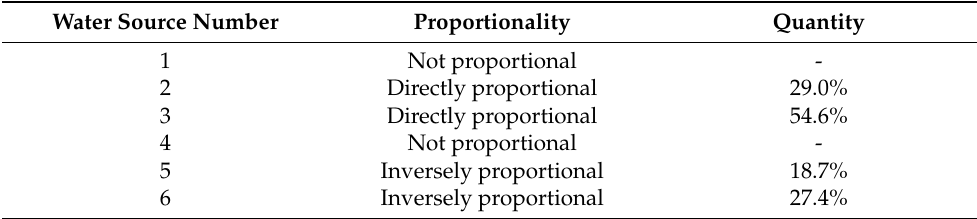
Table 2. Part of the dependencies identification algorithm output which is of interest. Water Source Number Proportionality